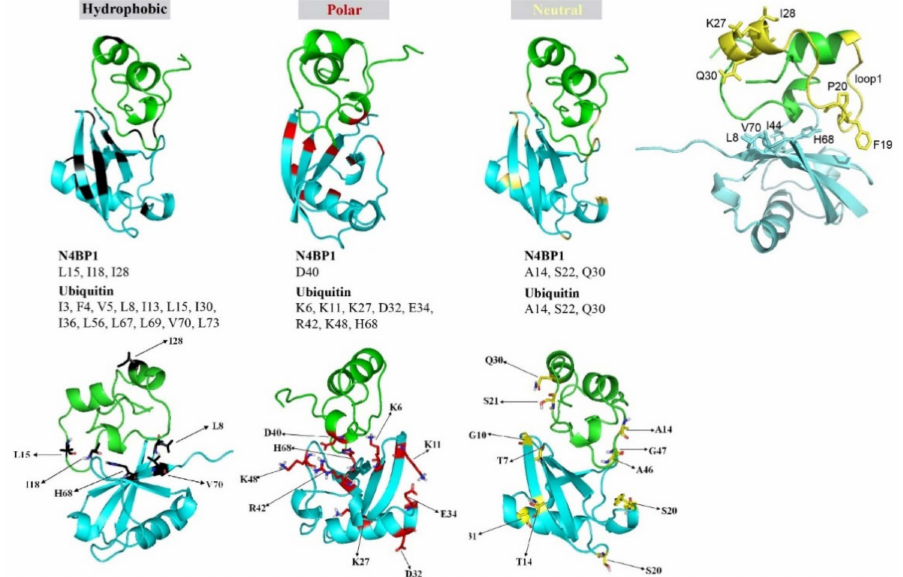
Figure 6. Conformational model of the N4BP1 / ubiquitin complex obtained by combining the structural model of N4BP1, the structure of ubiquitin (BMRB 6457 and PDB 1D3Z), and the reported chemical shift perturbation (CSP) values (upper panels). Colors indicate the nature of the residues influenced by the interaction. Black: hydrophobic residues, red: polar residues; yellow: neutral residues. Sticks represent side chains of the amino acids whose 15 N resonances are perturbed upon interaction with ubiquitin (lower panels). The distal residues K27, I28, and Q30 in helix-2 show significantly perturbed 15 N resonances upon interaction of N4BP1 with ubiquitin. Structural model showing residues in helix-2 (K27, I28, and Q30) that are perturbed in the N4BP1 / ubiquitin complex. The side chains of the FP